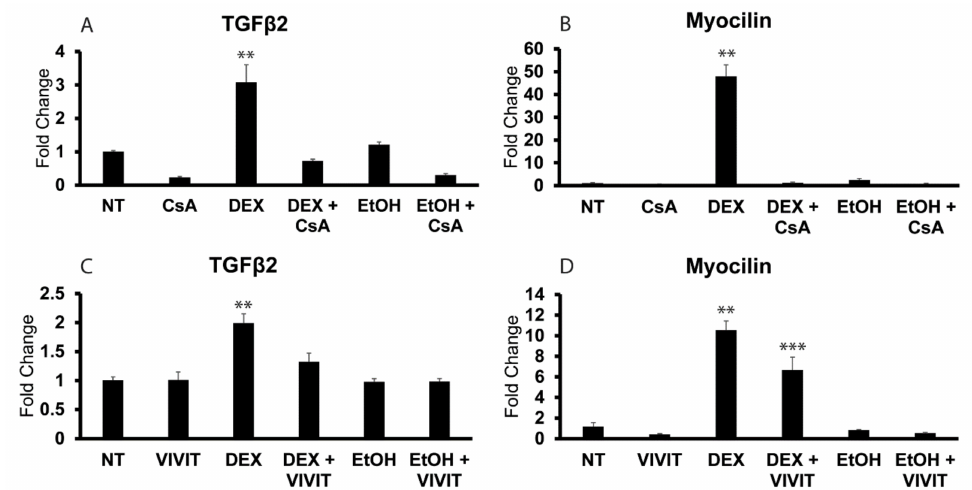
Figure 7. Inhibition of NFATc1 blocks DEX-induced TGF β 2 and myocilin mRNA increases in prolif- erating HTM cells. Subconfluent cultures of HTM cells were left untreated or were treated with DEX or EtOH for 72 h in the presence or absence of 10 µ M CsA ( A , B ) or 30 µ M 11R-VIVIT peptide ( C , D ). RT-qPCR analysis was used to determine mRNA levels of TGF β 2 and myocilin. Panels ( A , B ), TGF β 2 and myocilin mRNA levels in response to DEX only were significantly greater than NT, EtOH or DEX + CsA, ** p < 0.01. Panels ( C , D ), TGF β 2 and myocilin mRNA levels in response to DEX only were significantly greater than NT, EtOH or DEX + VIVIT, ** p < 0.01. DEX + VIVIT significantly >